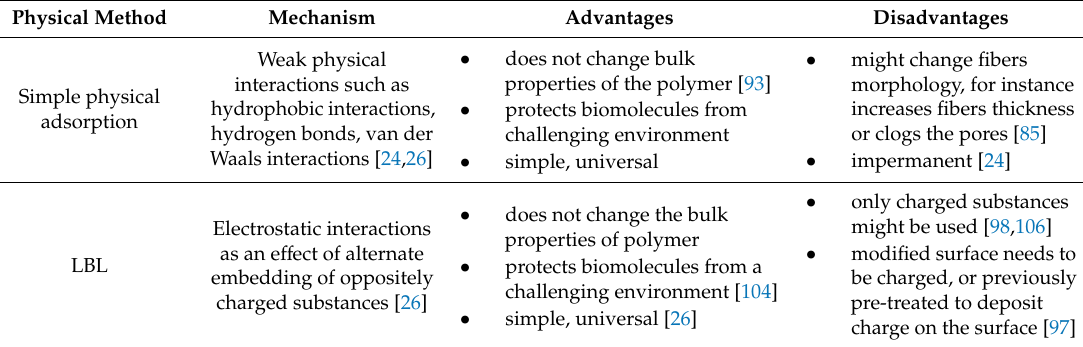
Table 2. Comparison of electrospun nanofibers physical hydrophilic functionalization